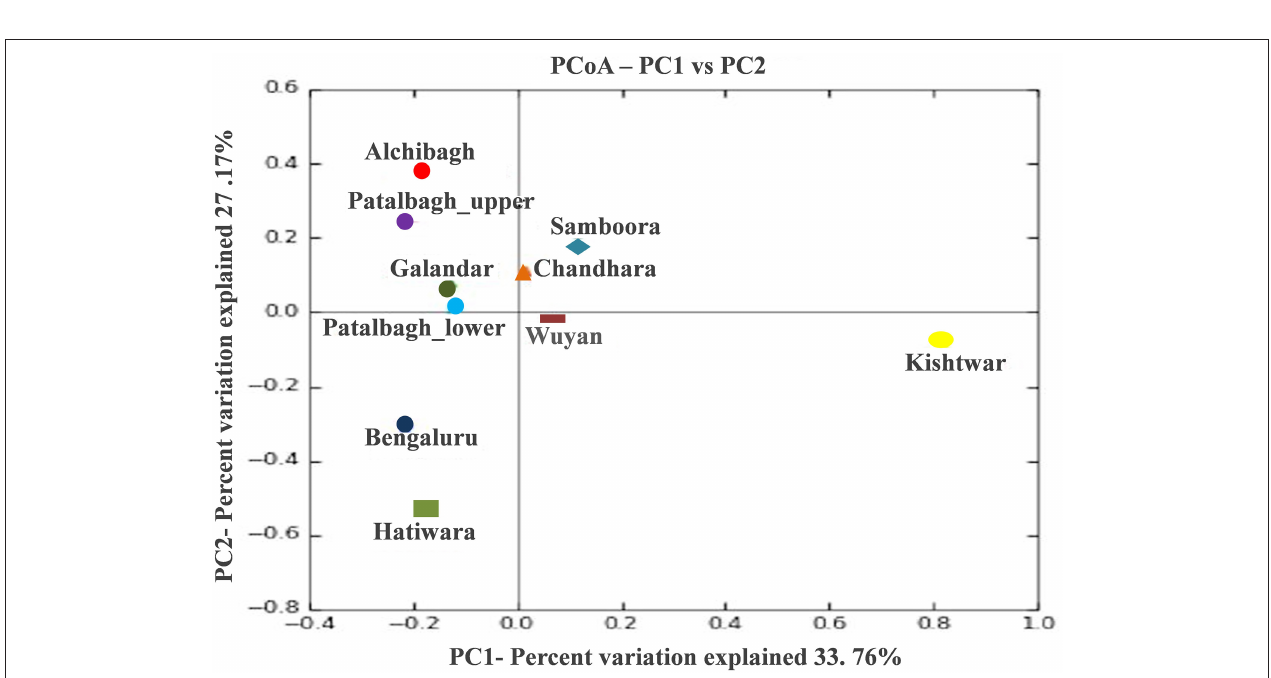
FIGURE 8 | PCOA plots representing the bacterial diversity of Kishtwar is significantly different from rest of sample as it doesn’t cluster with rest of the sample.